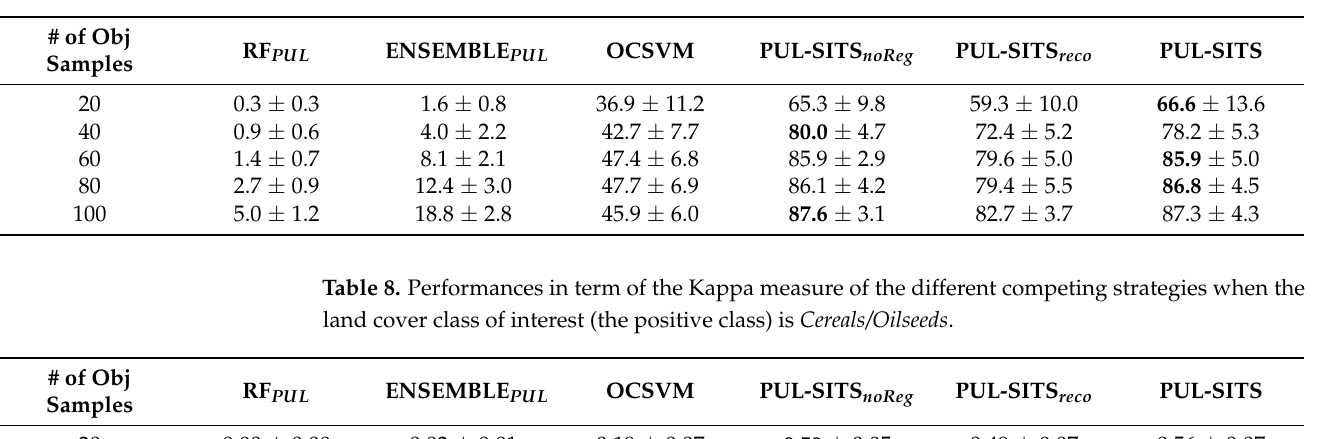
Table 7. Performances in term of the Specificity of the different competing strategies when the land cover class of interest (the positive class) is Cereals/Oilseeds .